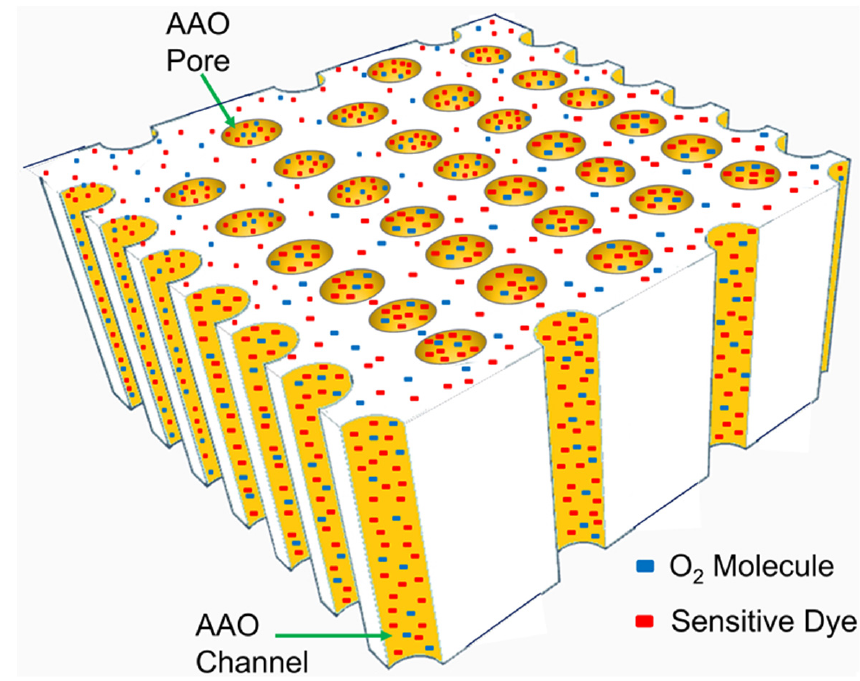
Figure 1. Schematic diagram of AAO through-hole membrane with dye molecules.